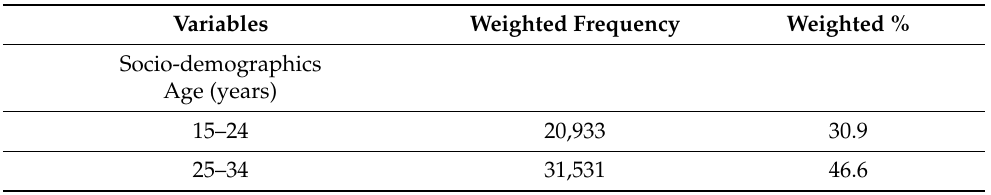
Table 1. Characteristics of women within reproductive age in South Africa and factors influencing the use of antenatal care among them ( n =